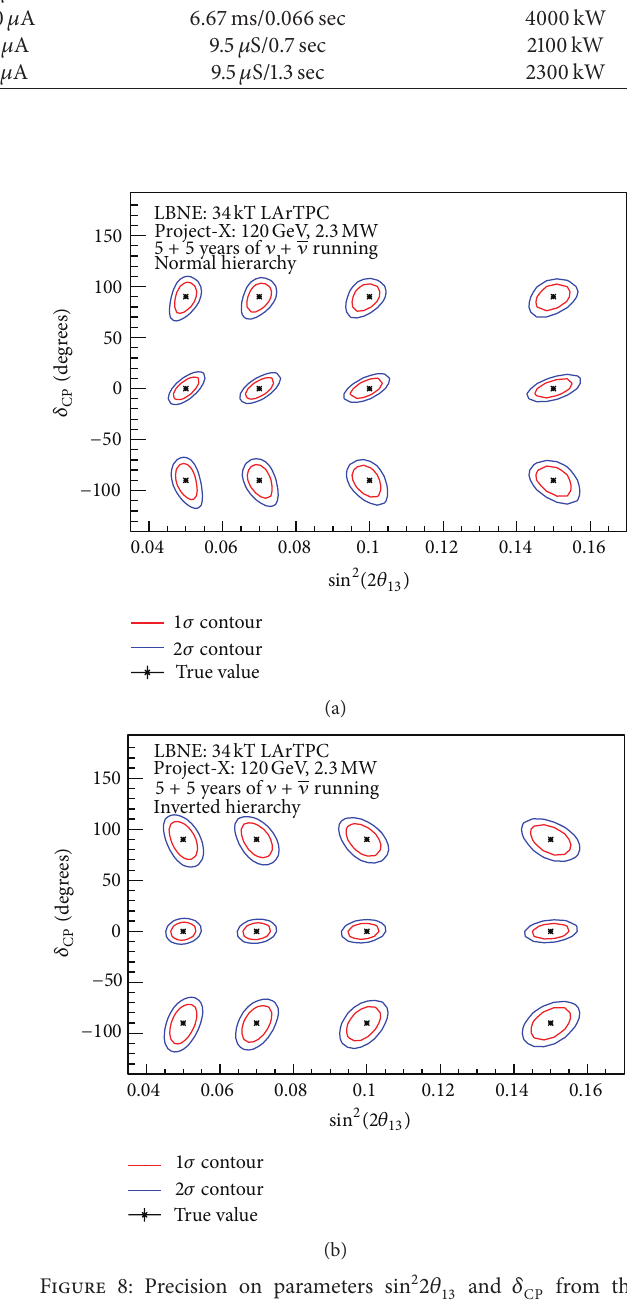
Figure 8: Precision on parameters sin 2 2𝜃 13 and 𝛿 LBNE configuration using high-intensity beam from Project-X. The precision is shown as for various true parameters across the 𝛿 and sin 2 2𝜃 13 space. This calculation was performed with the CP GLOBeS sensitivity calculation tool [24] which marginalizes over all oscillation parameters, except for the ones being fit, including the mass hierarchy using known errors. The long-baseline LBNE setup allows separation of matter and CP effects with no remaining ambiguities because of the length of the baseline and the broadband